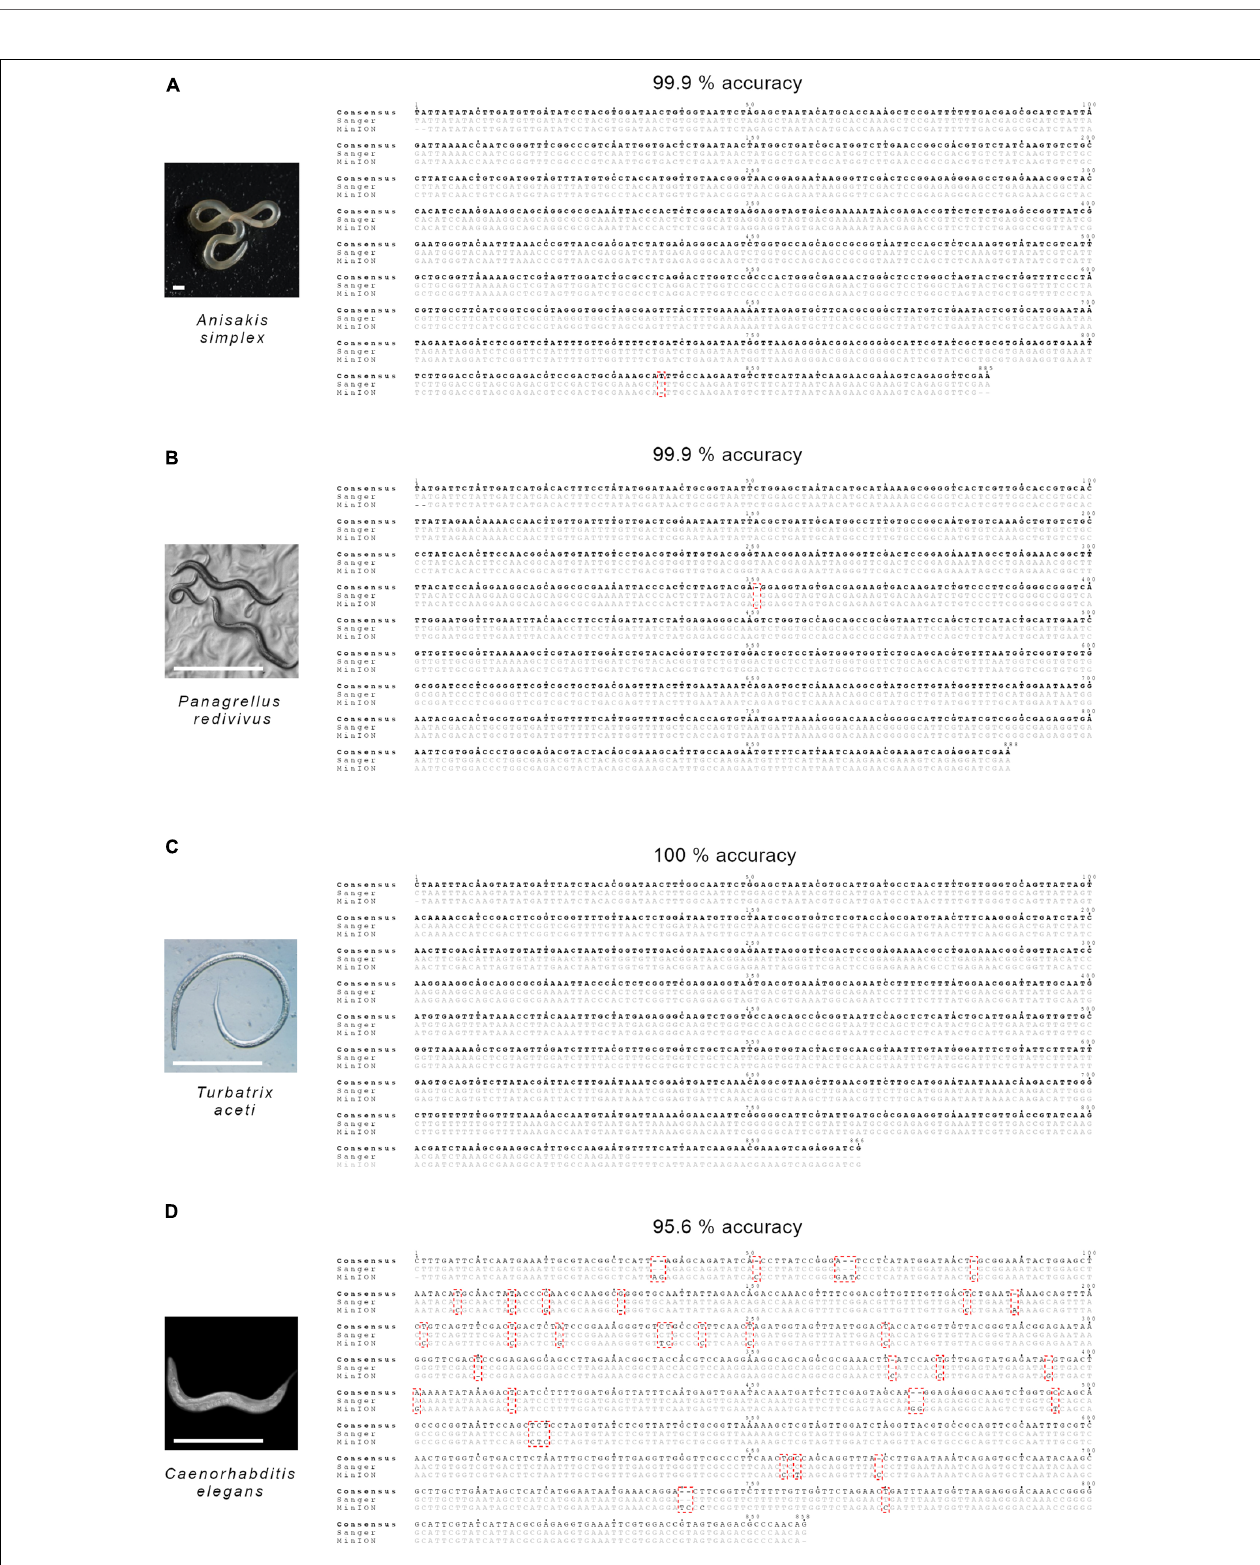
FIGURE 2 | Species investigated and nucleotide alignments of MinION and Sanger sequences comparing consensus accuracy for (A) A. simplex , (B) P. redivivus , (C) T. aceti , and (D) C. elegans . Sanger sequences have a 100% accuracy. Accuracy shown is the accuracy of the MinION consensus reads. Comparison against accession numbers MF072711.1 ( A. simplex ), AF083007.1 ( P. redivivus ), AF202165.2 ( T. aceti ), and MN519140.1 ( C. elegans ). The scale bar in the photographs of (A–C) represents 1 mm and in (D) represents 0.5 mm.